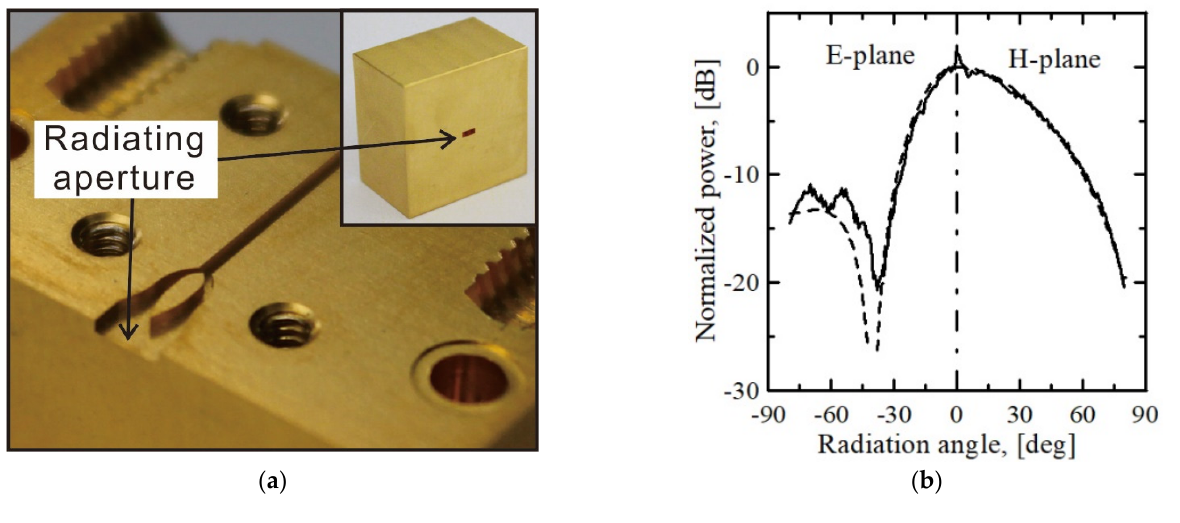
Figure 5. Open-end array module test. ( a ) Photograph showing the bottom half and the fully assembled open-end module; ( b ) measured (solid) and theoretical (dashed) E- and H-plane patterns.